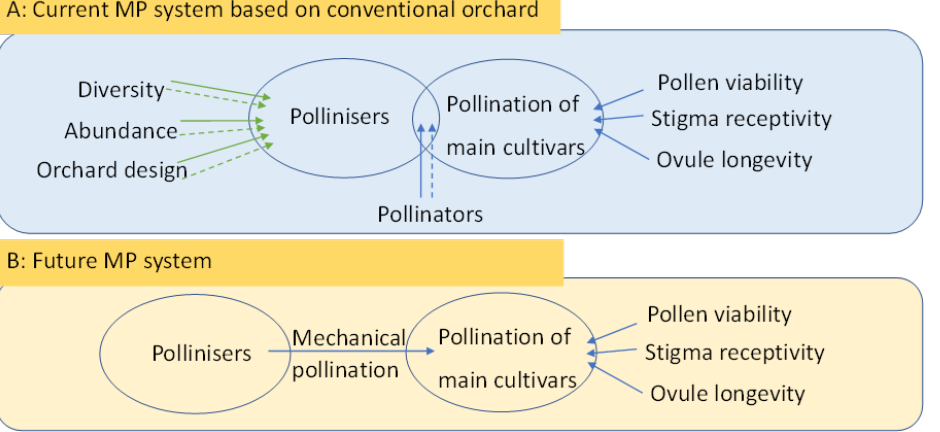
Figure 1. Conceptual diagram of the factors influencing cross-pollination of fruit and nut crops for a polliniser and pollinator model production system ( A ) with (solid line) or without (dashed line) a mechanical pollination (MP) system whereby factors with dotted lines would have reduced influence under a MP system, or ( B ) MP only where pollinisers are grown in a separate orchard. In both scenarios, the same environmental conditions and agronomic management practices would apply. Table 1. Factors contributing to pollination deficiency in fruit and nut crops, and potential benefits of mechanical pollination (MP) systems.